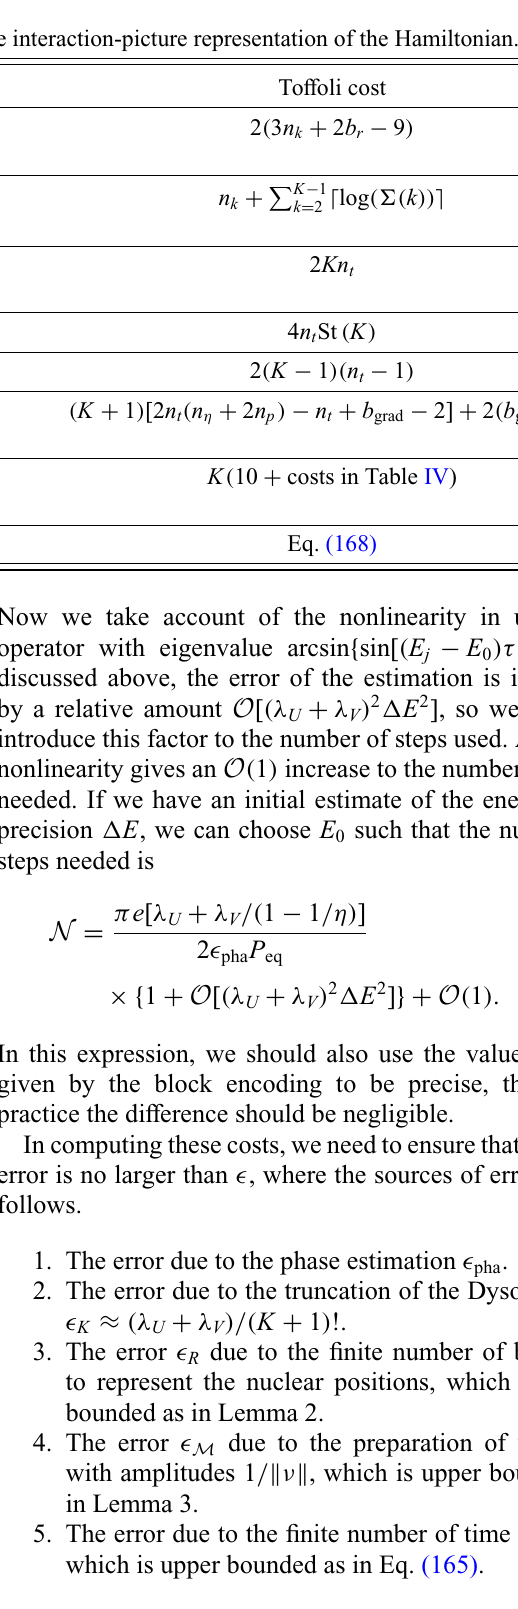
TABLE V. The costs involved in the block encoding of the interaction-picture representation of the Hamiltonian. Procedure Toffoli cost The preparation of the equal superposition over (cid:21)( 0 ) numbers; see Eq. (161). Inequality tests used for the preparation of the superposition over k ; see Eq. (162).